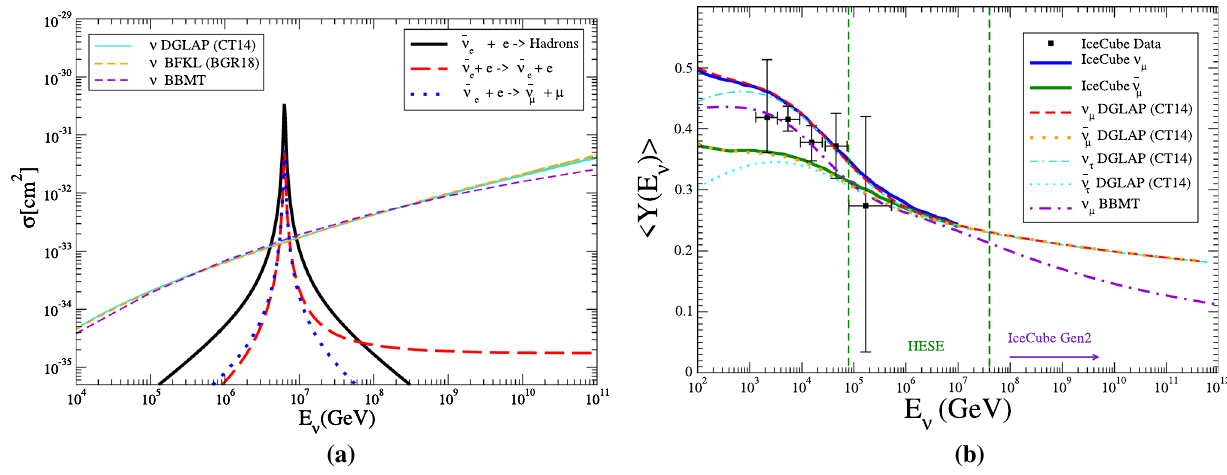
Fig. 4 a Energy dependence of the neutrino-target cross-section considering different models for the QCD dynamics; b predictions for the energy dependence of the average inelasticity. For comparison, the data and theoretical predictions from [13] (solid lines) are also presented